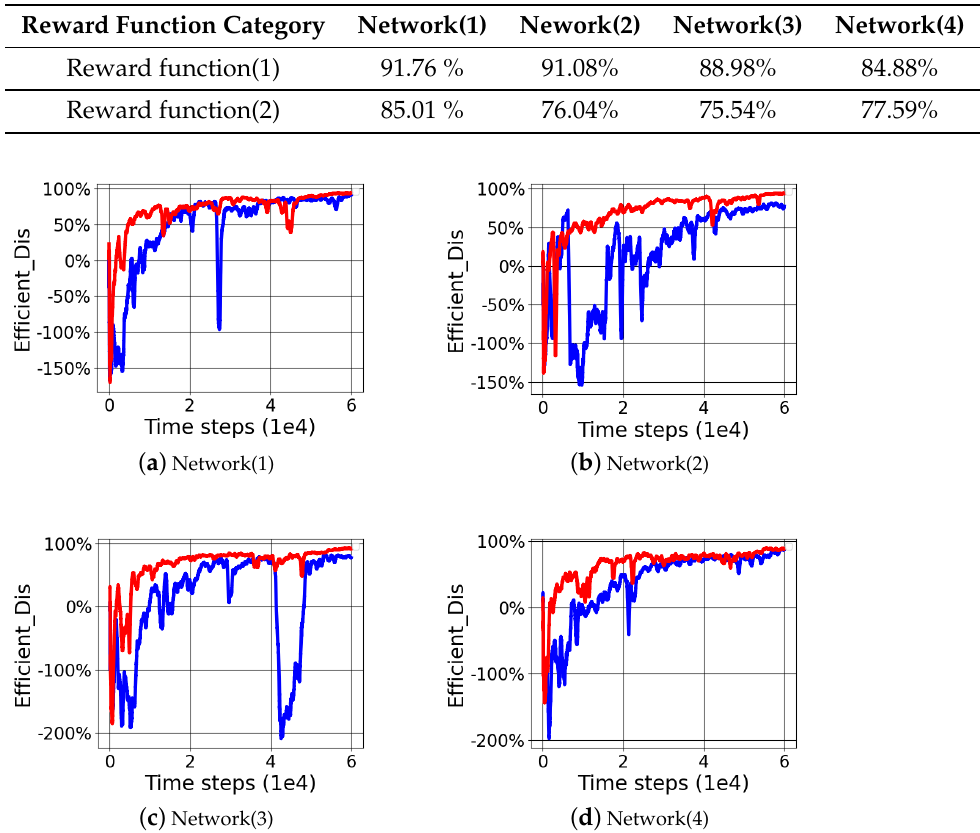
Table 6. The efficient distances of reward function(1) and reward function(2) for four times of randomly initialized network node parameters.